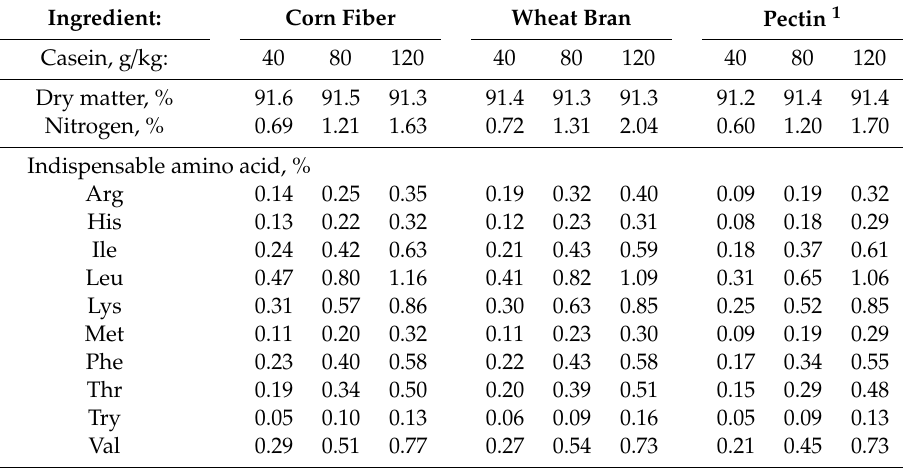
Table 3. Analyzed dietary amino acid contents of the diets fed to broiler chickens (as fed basis; Exp.